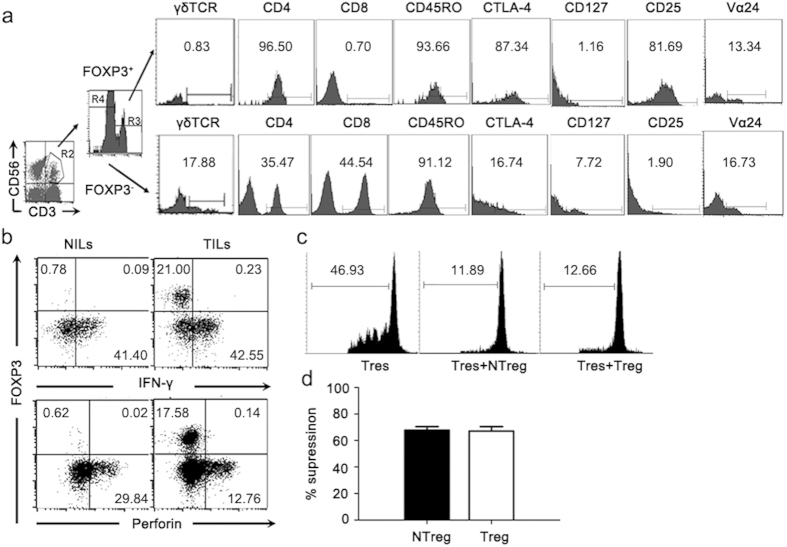
Comparative analyses of FOXP3+CD3+CD56+ cells versus CD3+CD56+FOXP3– cells and the immunosuppressive function of FOXP3-expressing CD3+CD56+ cells in tumor tissues of HCC patients in vitro.Analyses were repeated with samples from 8–10 HCC patients with similar results. Data from a representative patient is shown. (a) CD3+CD56+ cells in TILs were divided into FOXP3+ and FOXP3– subsets and analyzed for surface expression of γδ TCR, CD4, CD8, CD45RO, CTLA-4, CD127, CD25 and Vα24. (b) TILs or NILs from HCC patients were stimulated with Phorbol-12-myristate-13-acetate (50 ng/ml) and ionomycin (1 μg/ml) for 4 hours. FOXP3 and IFN-γ or Perforin expression in CD3+CD56+ cells were subsequently analyzed by flow cytometry. The numbers in the dot plots indicate the percentages of the corresponding subsets. (c) The anti-proliferative effect of tumor infiltrating FOXP3+CD3+CD56+ cells on CD4+CD25– responder T cells. FOXP3+CD3+CD56+ cells were isolated and purified from the TILs of HCC patients and the CD4+CD25- responder T cells were from autologous PBMC. Histograms represent CFSE dilution of labeled autologous CD4+CD25– responder T cells cultured alone (Ctr) or at a 2: 1 ratio with Treg cells (Treg) or FOXP3+CD3+CD56+ cells (NTreg). Percentages of responder T cell proliferation are indicated. Data are representative of three independent experiments from three individual HCC patients. (d) The comparison of the proliferation-inhibitory effect of FOXP3+CD3+CD56+ cells (NTreg) with Treg cells from three HCC donors. The inhibitions of proliferation were normalized to proliferation of responder cells alone.